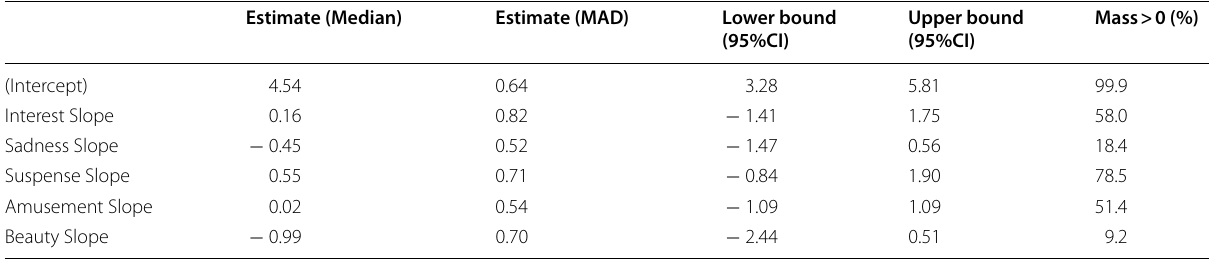
The median, median absolute difference, 95%CI and mass > 0 of the posterior distribution are given